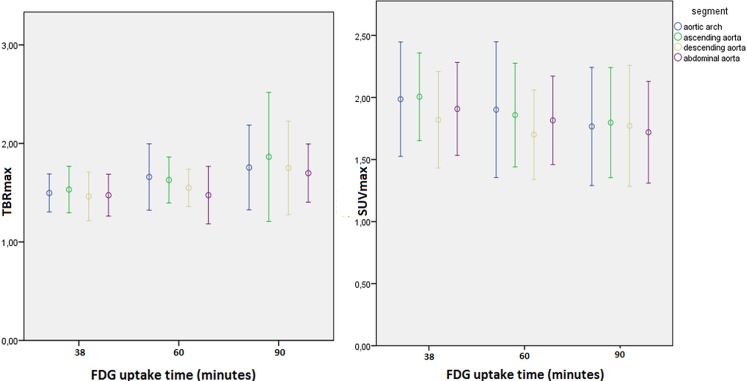
Clustered error plots of TBRmax and SUVmax at all three uptake times in the vascular segments of the aorta.